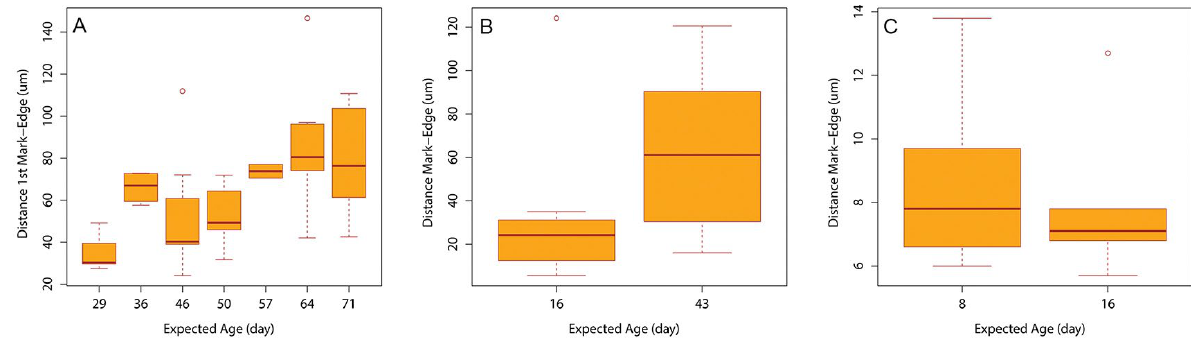
Fig. 1. – Box-plots showing the relationship between the otolith growth (as distance from the ALZ mark to the edge) and the expected age. A, A. minuta ; B, P. ferreri ; C, C. linearis.